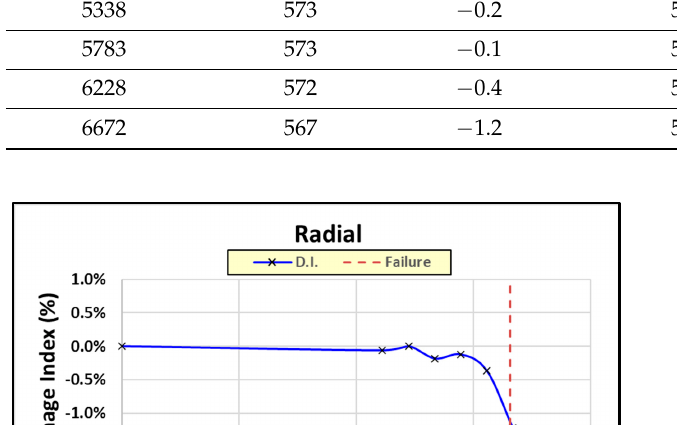
Table 5. Load and damage index (DI) sensor #11.